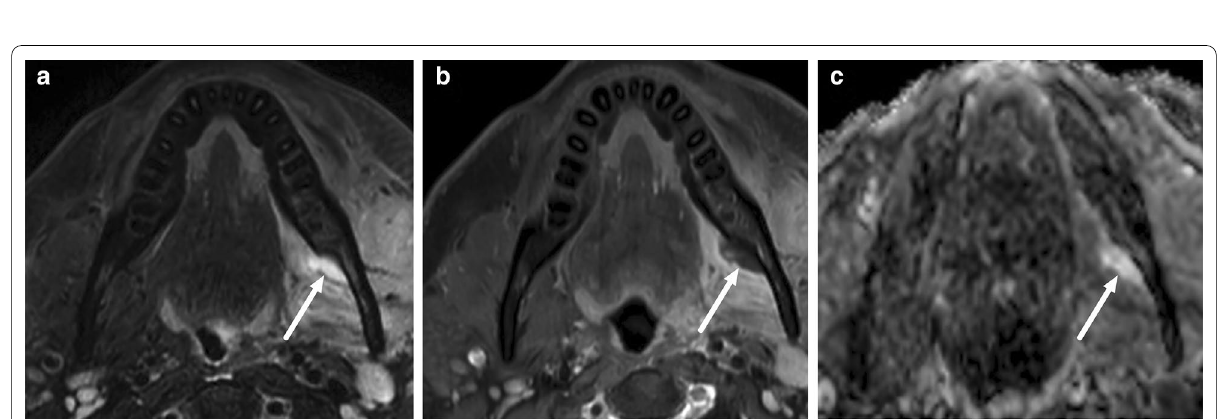
Fig. 35 Sterile subperiosteal collection (arrows) after oral surgery on axial fat-suppressed axial T2-weighted ( a ) and post-contrast T1-weighted ( b ) images and ADC ( c ). High ADC values suggest sterile fluid rather than